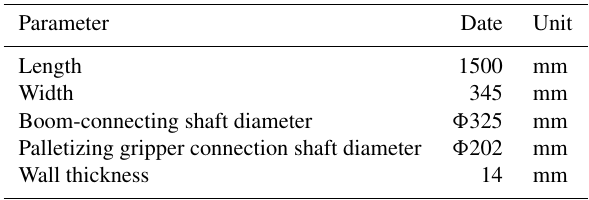
Table 1. Main parameters of the manipulator model.